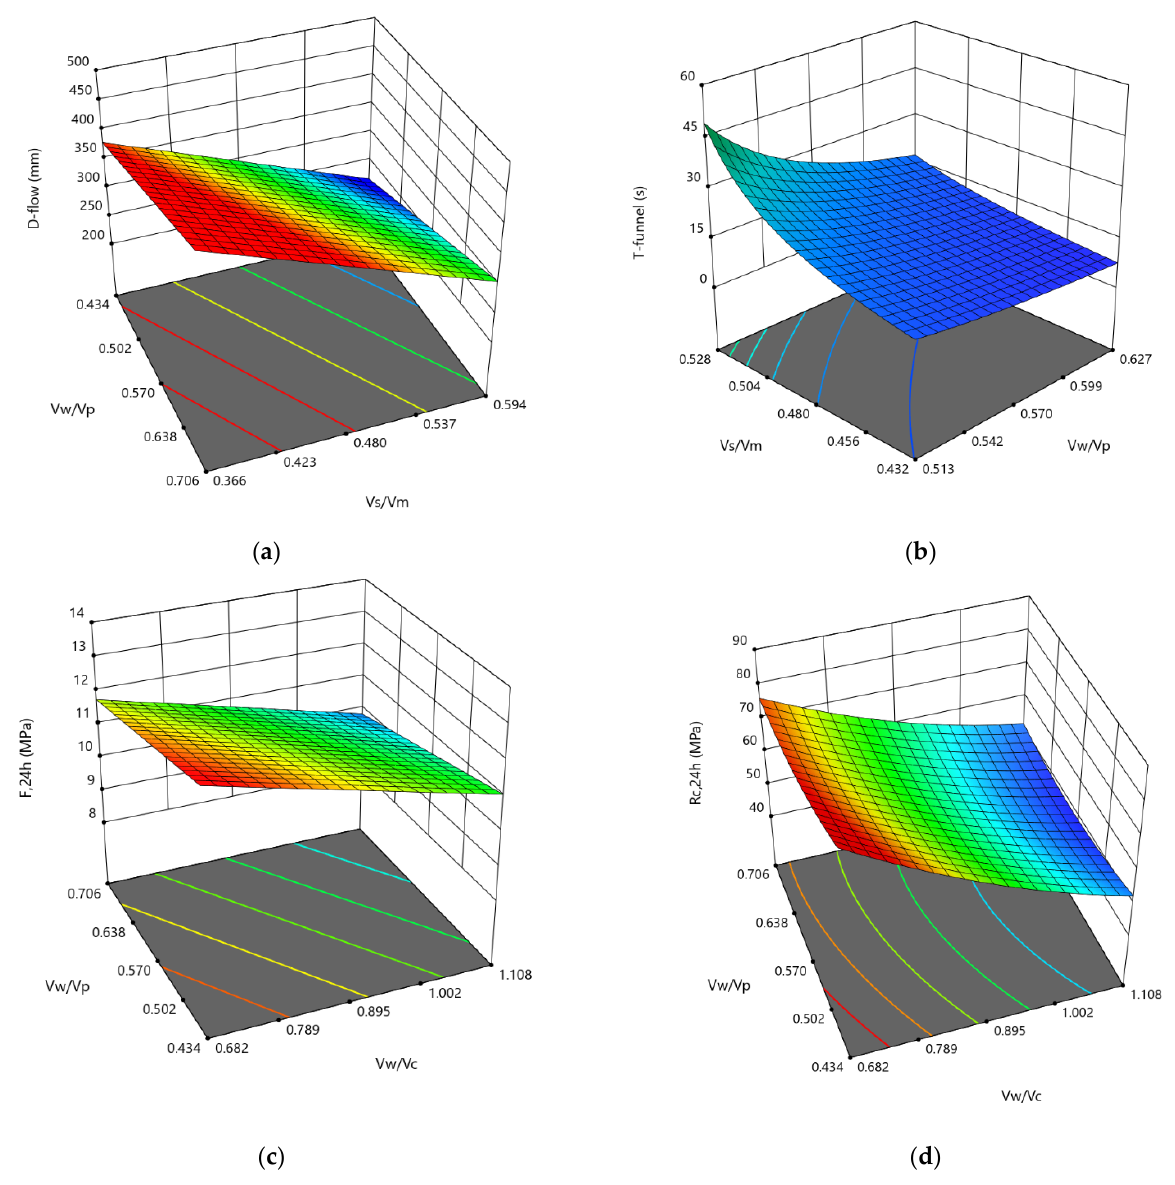
Figure 9. Effect of the Vs/Vm and Vw/Vp ratios on ( a ) D-flow and ( b ) T-funnel; effect of Vw/Vc and